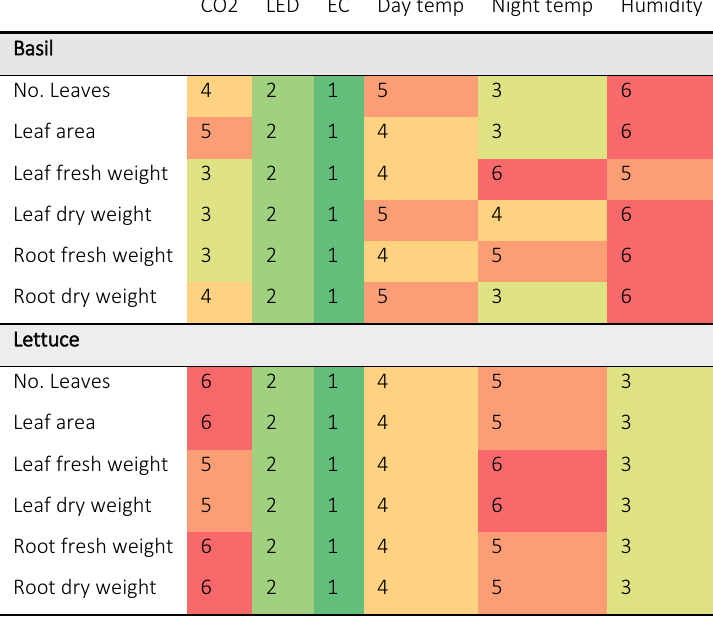
Table 4. Ranking the effect of environmental factors on basil and lettuce growth parameters based on S/N